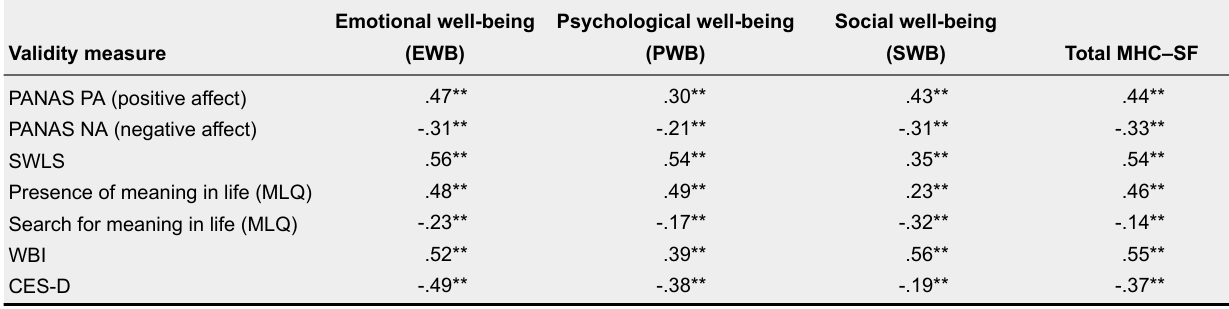
MHC-SF. Bivariate Correlations with Validation Measures